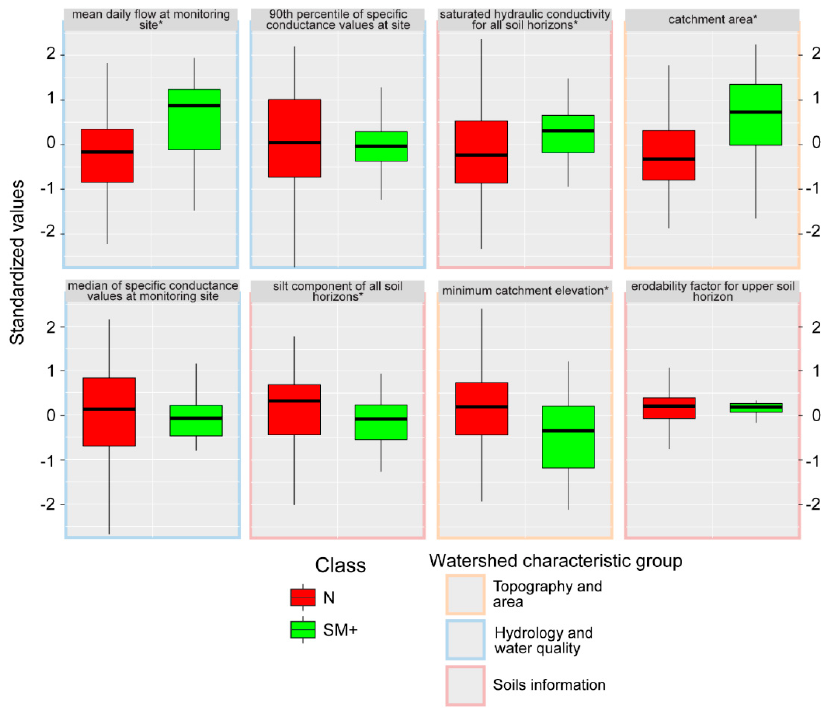
Figure 5. Distribution of standardized watershed characteristic values for eight most important variables in optimized exploratory random forests models. * Denotes p -value < 0.05 for Wilcoxon rank-sum test on SM+ and N classes for unscaled watershed characteristic values. See Table S4 for all standardized values and Wilcoxon rank-sum results.